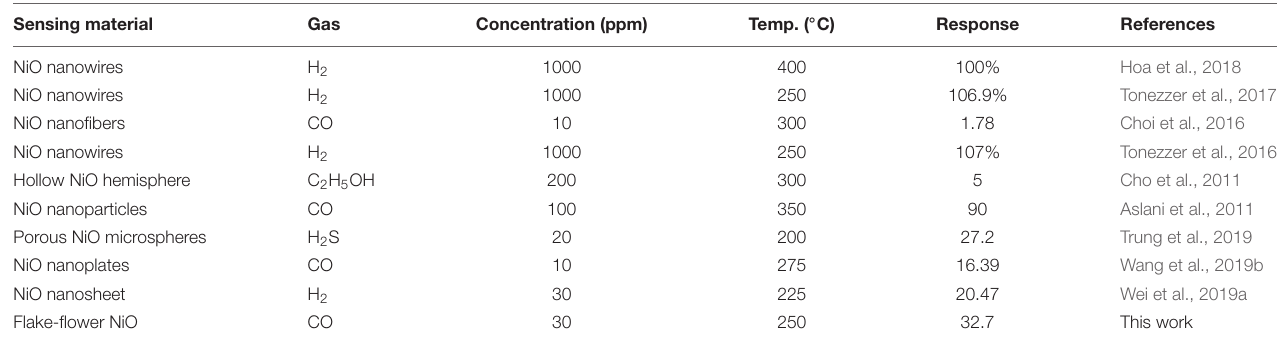
TABLE 1 | Summary of recent researches on NiO based sensors for sensing of toward different reducing